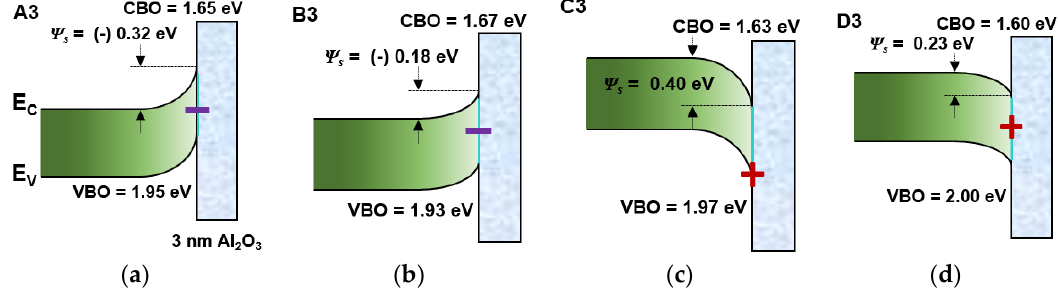
Figure 5. Energy band bending at 3 nm Al 2 O 3 /GaN interfaces with Ψ s, VBO, and CBO of samples ( a ) A3, ( b ) B3, ( c ) C3, and ( d ) D3.